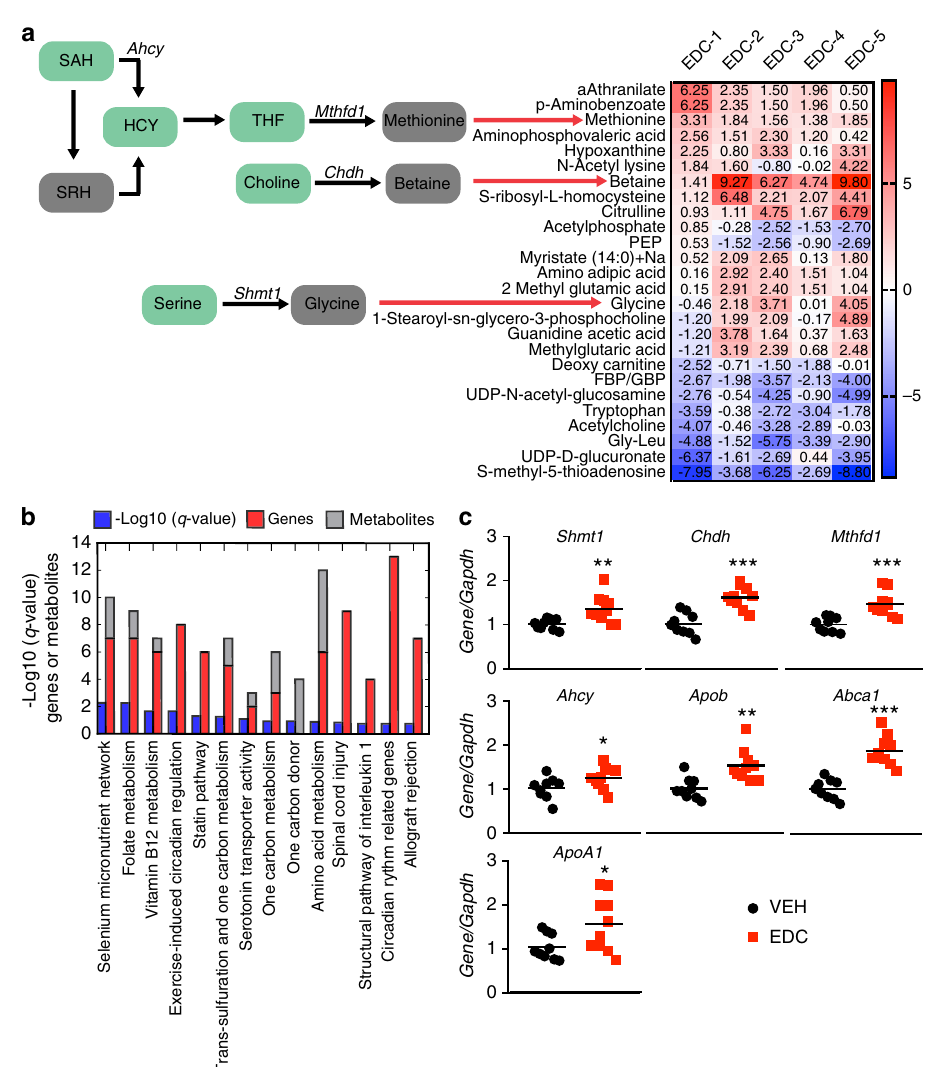
Fig. 4 Reprogramming by early-life EDC exposures causes metabolic disruption in the liver. a Targeted metabolomics of livers of animals fed a Western- style diet. For each metabolite and each EDC-exposed animal, we computed its z-score (number of standard deviations) compared to the vehicle-treated animals. N = 5 biologically independent animals per treatment. The results were visualized with a CBioPortal Oncoprint-type exploration tool, and metabolites increased by at least 1.5 standard deviations in at least 3 animals and down in none or decreased by at least 1.5 standard deviations in at least 3 animals and up in none are shown. Genes that encode enzymes associated with altered metabolites are depicted on the left in italics ( Ahcy , Mthfd1 , Chdh , and Shmt1 ). S-Adenosylhomocysteine = SAH, homocysteine = HCY, S-ribosyl homocysteine = SRH, tetrahydrofolate = THF, phosphoenolpyruvic acid